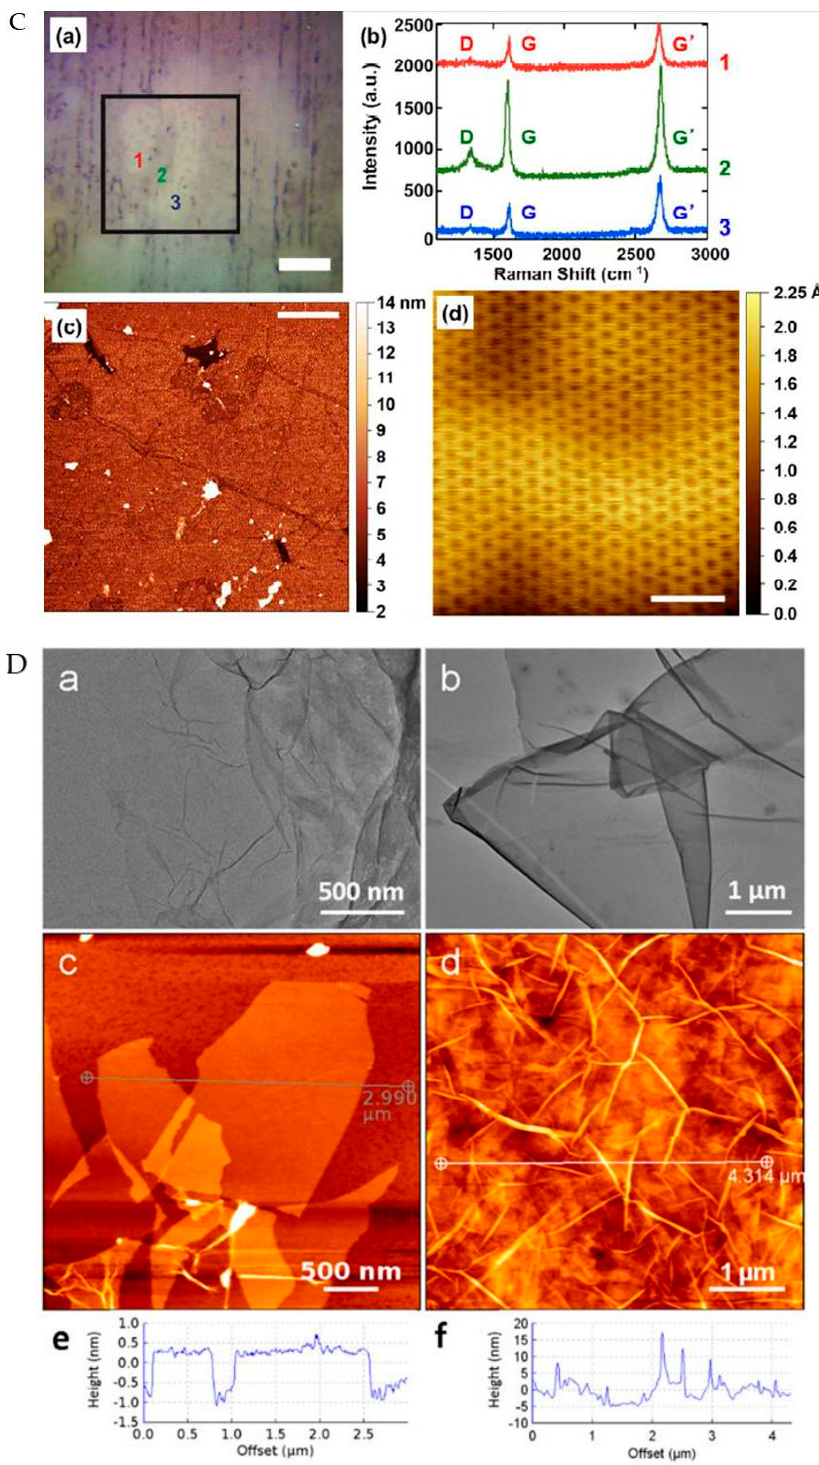
Figure 7. Synthesis and characterization of the graphene. ( A ) Chemical vapor deposition synthesis, ( B ) Liquid phase synthesis/exfoliation of graphite into GO and rGO [75], ( C ) Characterization of CVD graphene by ( a ) OM, ( b ) Raman and ( c , d ) STM [76], ( D ) TEM and AFM of GO ( a , c ) and rGO ( b , d ) and ( e , f ) are AFM height profiles of GO and rGO [77]. Pulse Laser Deposition (PLD), Atomic Layer Deposition (ALD), Molecular Beam Epitaxy (MBE), Metal-Organic CVD. Graphene (Gr), Chemical Vapor Transport (CVT). Reprinted/adapted with permission from refs. [75–77]. Copyright 2022, Springer Nature. Copyright 2013, ACS. Copyright 2018,